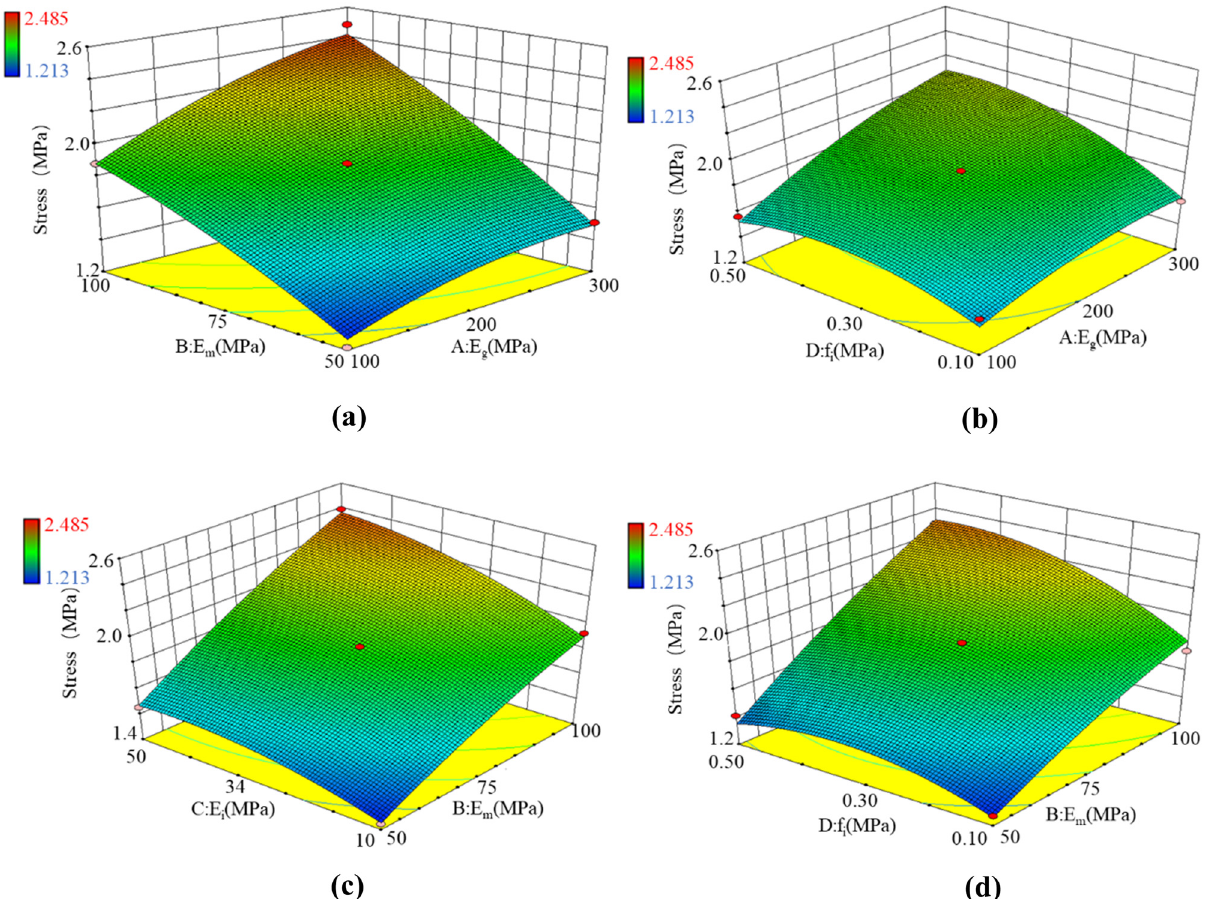
Figure 6: Comparative analysis of the in fl uence of interaction terms on σ 3 . ( a ) The in fl uence of AB interaction term on σ 3 . ( b ) The in fl uence of AD interaction term on σ 3 . ( c ) The in fl uence of BC interaction term on σ 3 . ( d ) The in fl uence of BD interaction term on σ 3 .